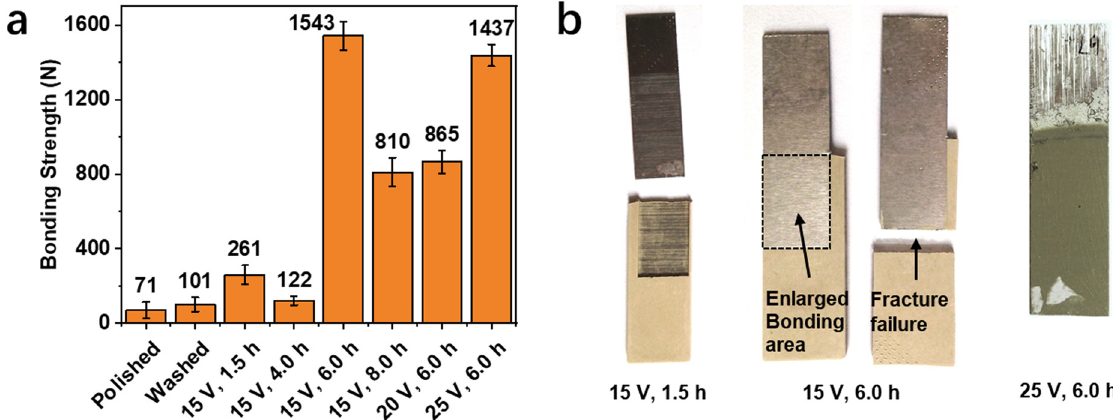
Figure 4: The tensile testing results: ( a ) the bonding strength results and ( b ) the PMH sample after tensile